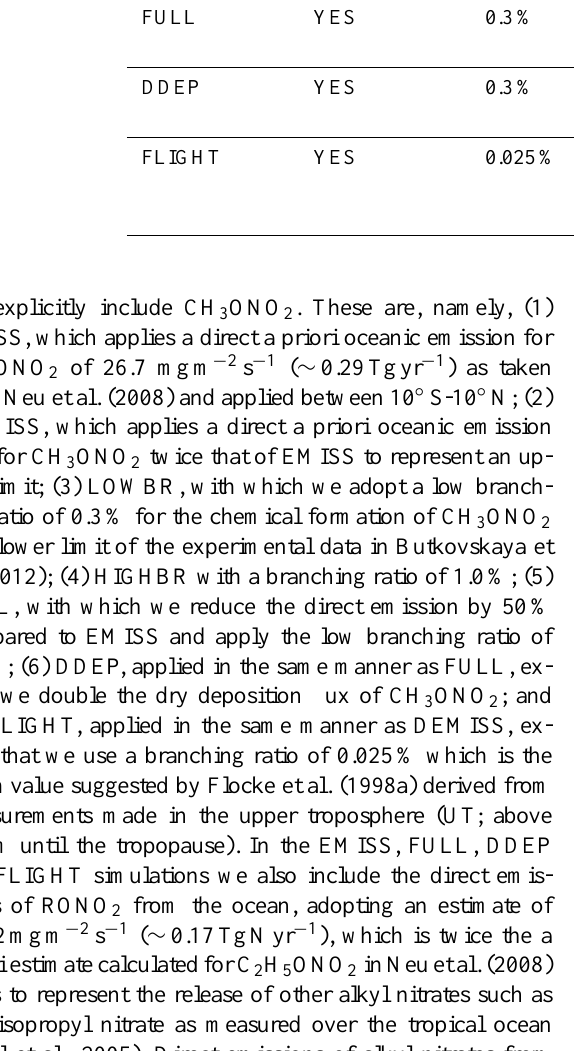
Table 2. An overview of the sensitivity studies performed with TM5 to investigate the impact of the chemical production of CH 3 ONO 2 on global tropospheric composition. Model Direct oceanic Branching ratio Default modified CB05 chemistry with- out CH 3 ONO 2 and no oceanic emis- sions Adopting the emission estimates for CH 3 ONO 2 from Neu et al. (2008) be- tween 10 ◦ S and 10 ◦ N Adopting an emission twice that of Neu et al. (2008) between 10 ◦ S–10 ◦ N 0.3% Lower uncertainty range from Butkovskaya et al. (2012) 1.0% Branching ratio measured by Butkovskaya et al. (2012) Combined emissions (0.5 of EMISS) and direct production (as in LOWBR) 0.3% As FULL, except the dry deposition flux is increased by 100% 0.025% As DEMISS, except adopting the branching ratio suggested in Flocke